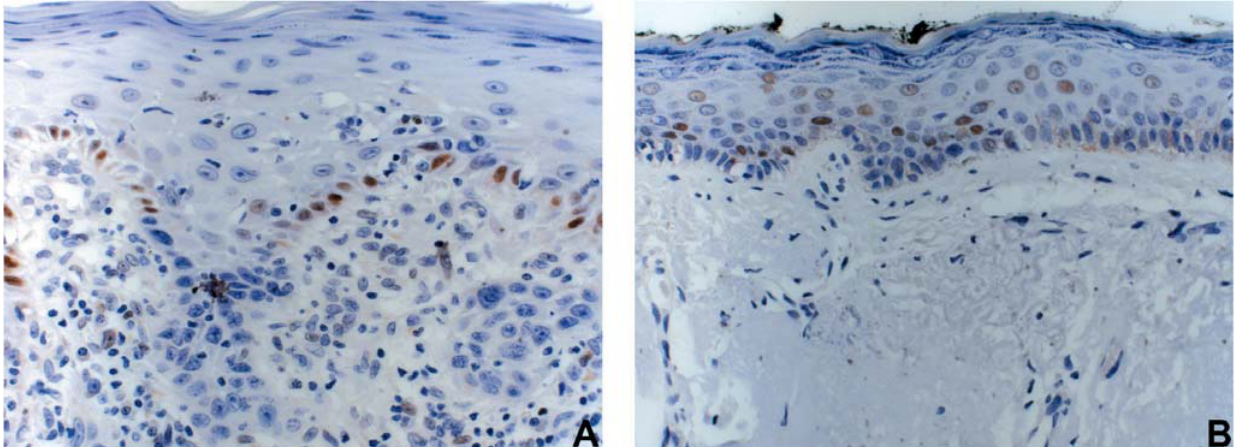
FIGURE 2 - Mild and Moderate epithelial dysplasia in actinic cheilitis. Discrete p53 nuclear immunostaining only in basal layer